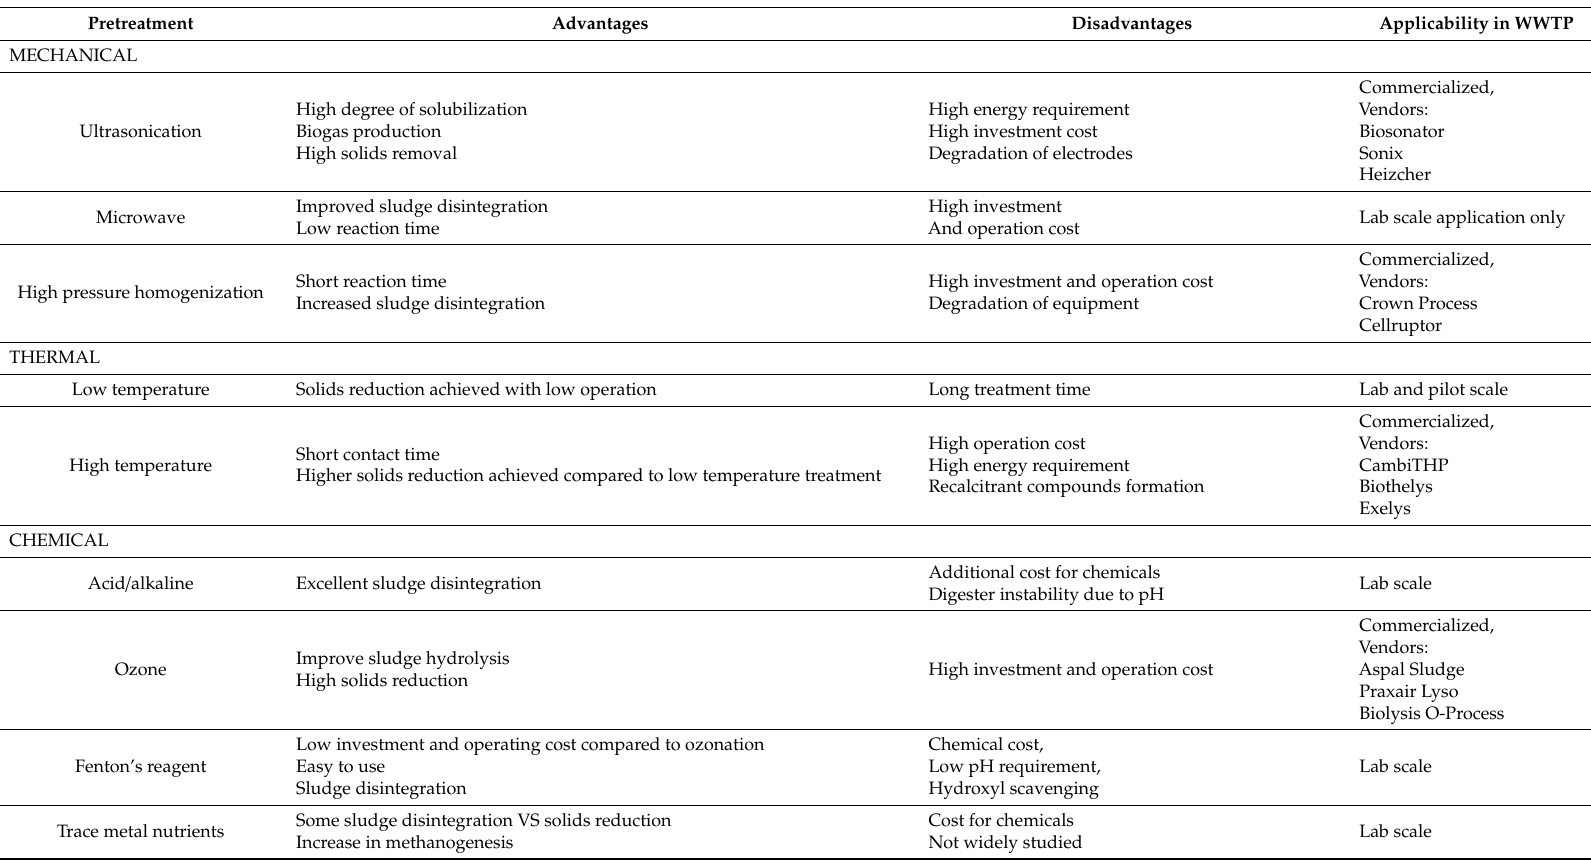
Table 3. Advantages and disadvantages of the pretreatment methods assessed via this review and their evaluated relative state of development with regard toward applicability at actual wastewater treatment plants